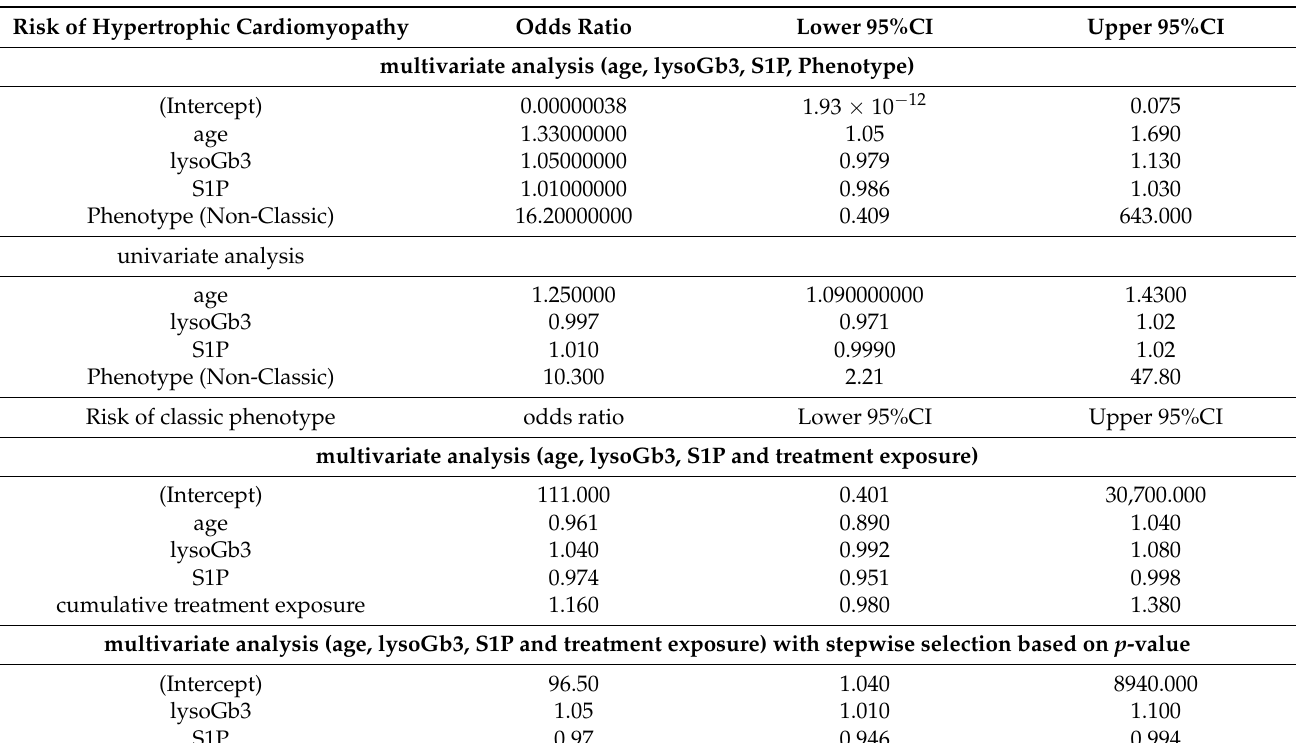
Table 2. Logistic regression analyses (S1P: